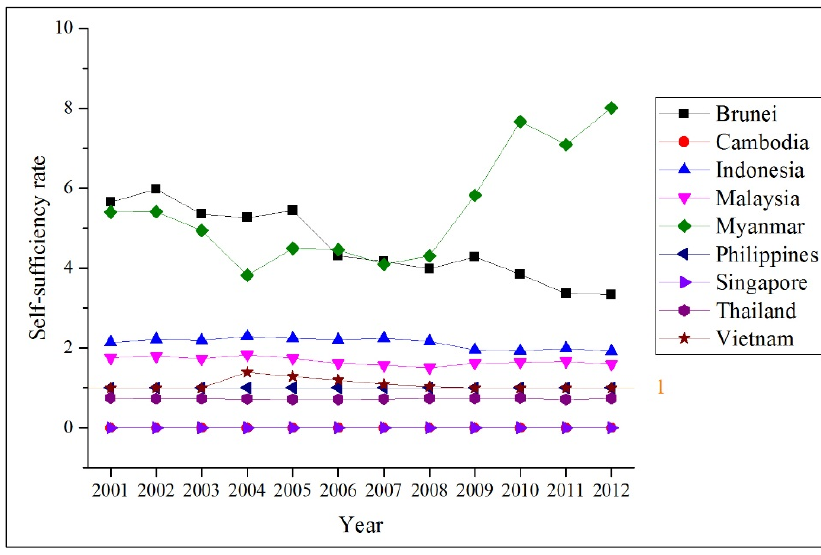
Figure 32. Natural gas self-sufficiency between 2001 and